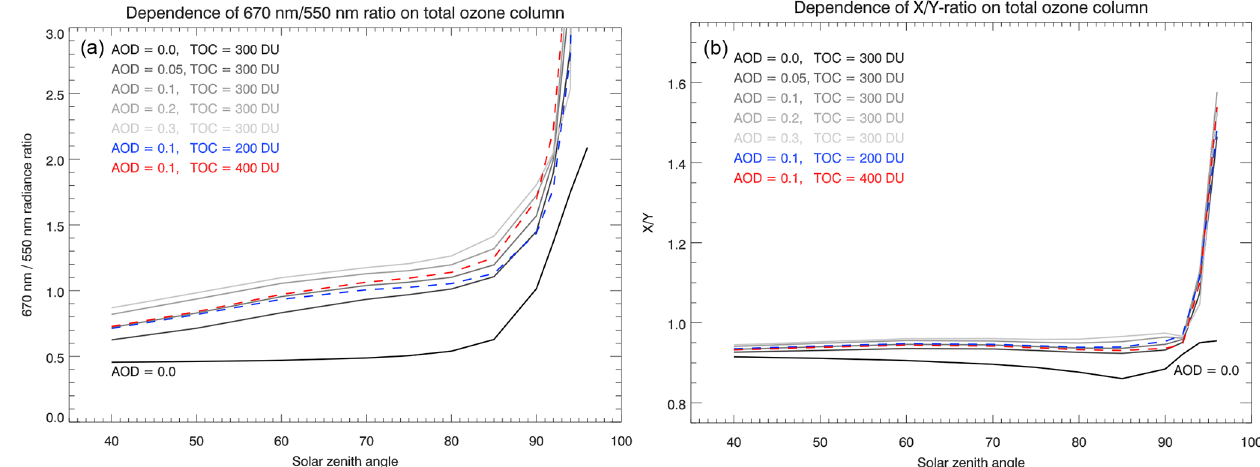
Figure 5. Ratio of the scattered solar radiances at 670 and 550nm (a) and the X/Y tristimulus value ratio (b) as a function of SZA and for different values of the stratospheric AOD and TOC. Other relevant parameters: VZA = 85 ◦ , SAA = 10 ◦ , A S = 0 . 3, r med = 250nm, S = 1 . 5.